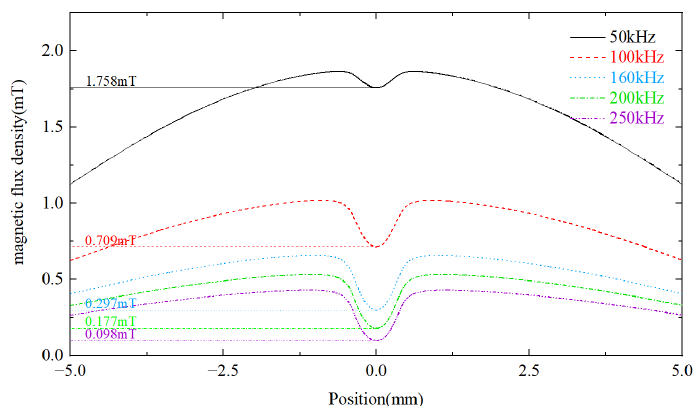
Figure 5. Distribution of the magnetic flux density along z-axis for non-ferrous metal debris.